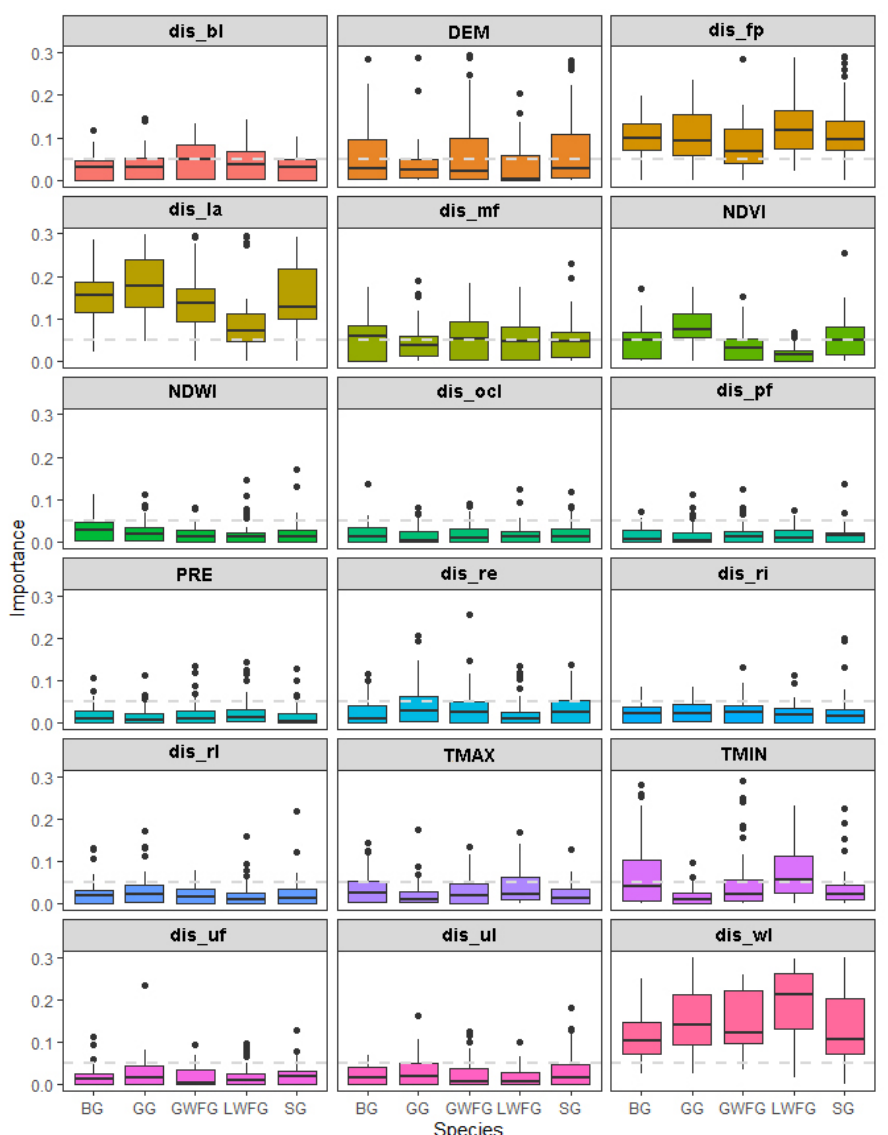
Figure 3. Box plots of interquartile range (IQR), range, and median model performance of algorithms used to predict the variable contribution to the model. The dots are potential outliers which are greater than the 75th percentile + 1.5 IQR or less than the 25th percentile − 1.5 IQR. The medians are represented by thick black lines. Lesser white-fronted goose (LWFG); greater white-fronted goose (GWFG); bean goose (BG); swan goose (SG); and greylag goose (GG). Because dis_la, dis_fp, and dis_wl are important for predicting suitable goose habitat areas, we compared the differences in these three variables in different periods. This study found that dis_fp and dis_la showed a downward trend from Period 1 to Period 4, while dis_wl showed an upward trend (Appendix B, Table A2). The results showed that the three variables exhibited significant differences in the four periods (ANOVA test, p < 0.01, Figure